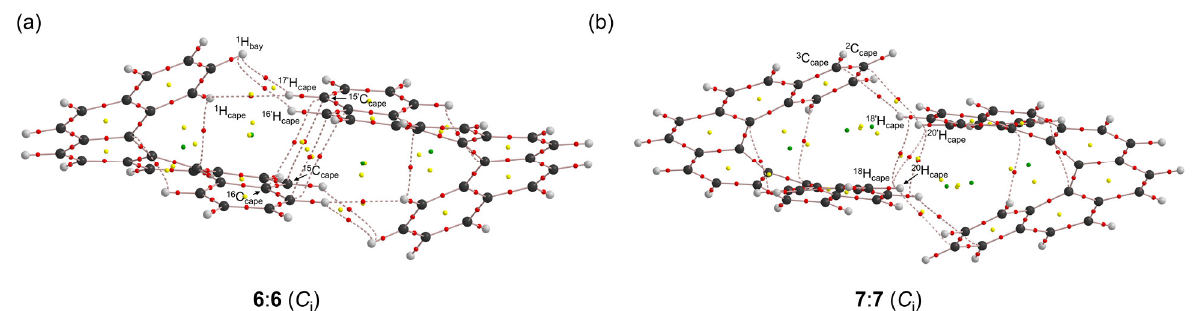
Figure 5. Molecular graphs for helicene dimers, 6 : 6 ( a ) and 7 : 7 ( b ), calculated with M06-2X/6- 311+G(3d,p), where BPs with BCPs corresponding to intra- and intermolecular noncovalent interac- tions are detected. The BCPs are denoted by red dots, RCPs (ring critical points) by yellow dots, CCPs (cage critical points) by green dots, and BPs by pink lines. The carbon atoms are in black and the hydrogen atoms are in grey.